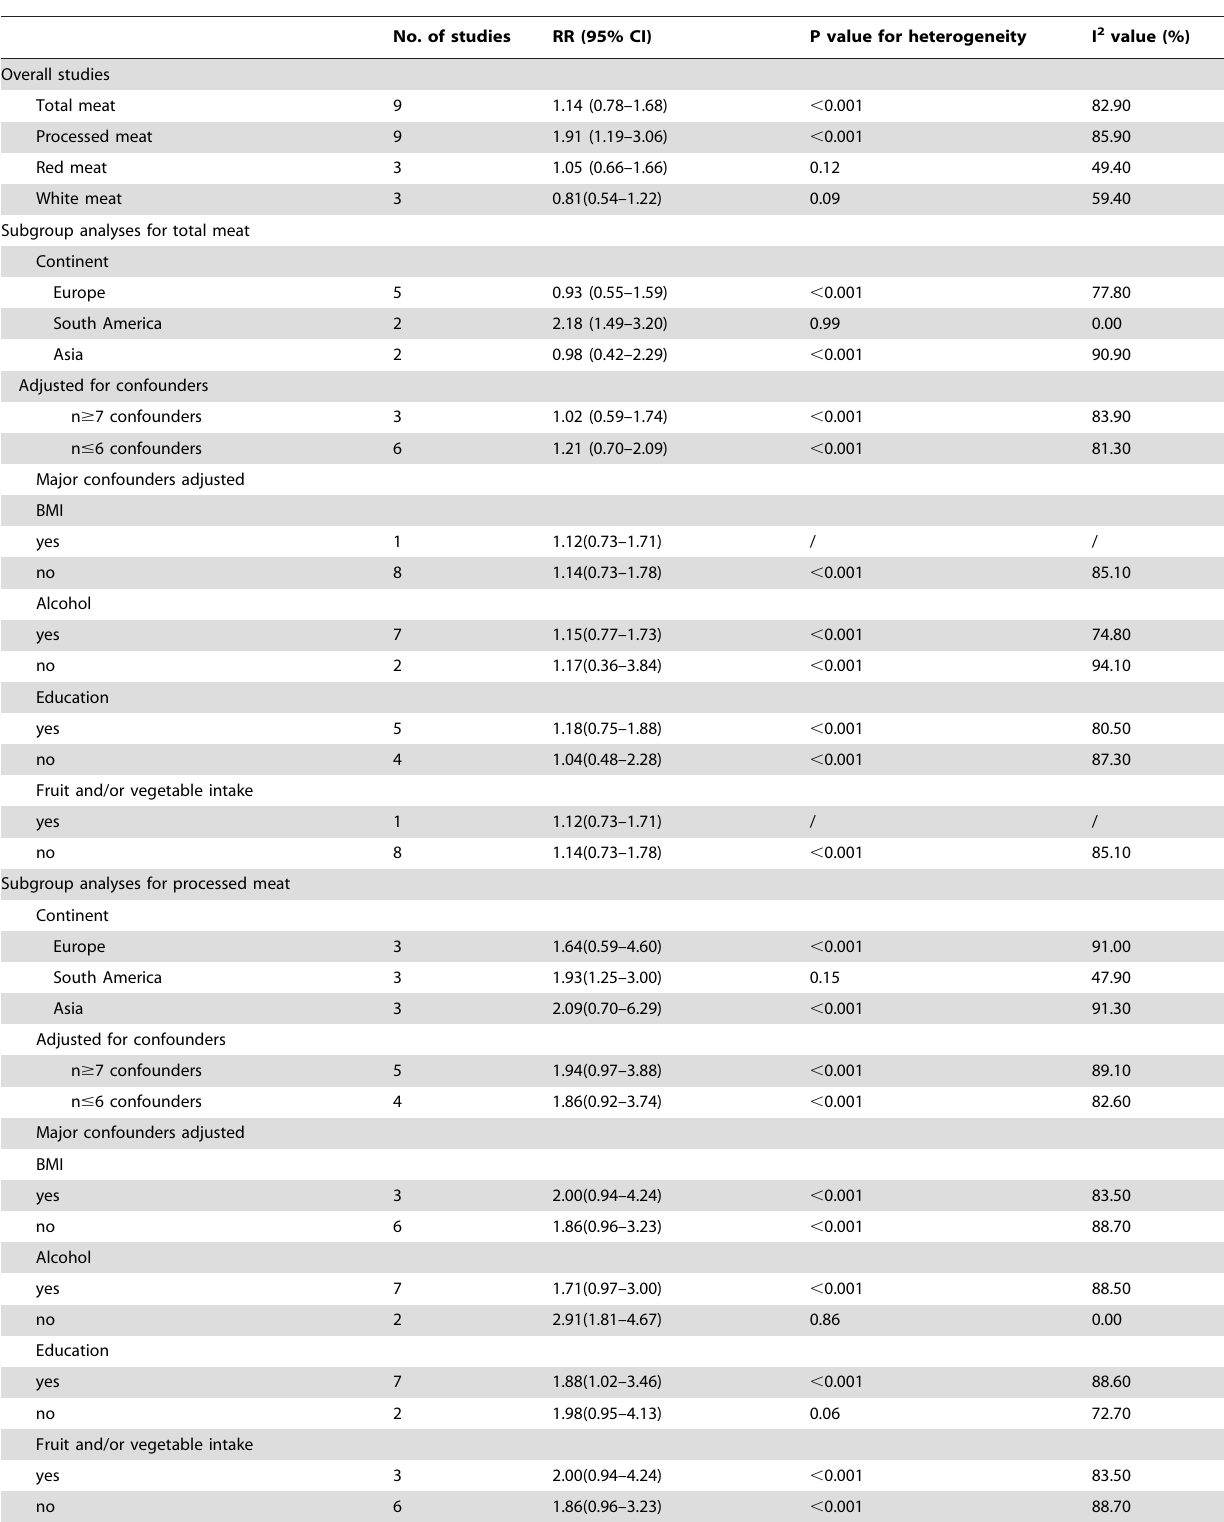
BMI= body mass index; CI=confidence interval; RR=relative risk.